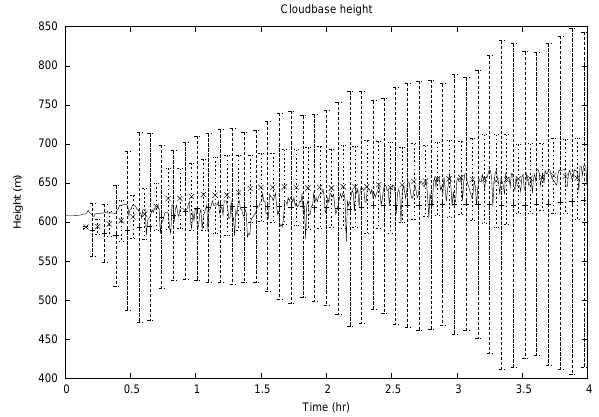
Fig. 2. Cloudtop height of DYCOMS-II simulation: the solid line shows results from our 2-D ERM. The inner error bars show the first and third quartiles of the ensemble of LEMs in the Stevens et al. (2005) intercomparison, the outer error bars show the maximum and minimum values of the ensemble. The mid-points of the error bars are marked by crosses and plus signs, respectively.